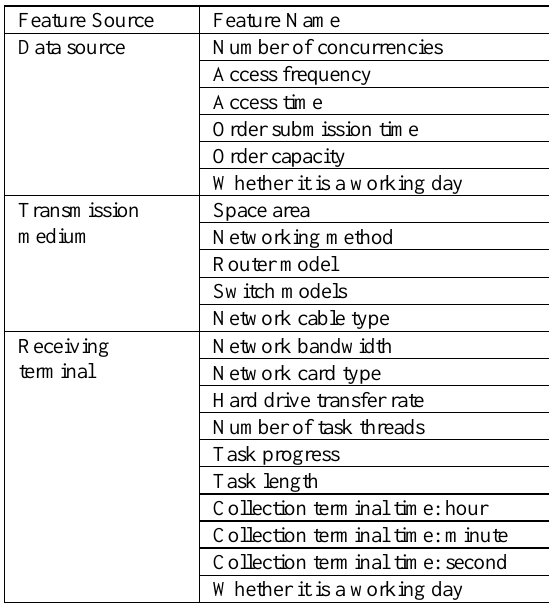
Table 1 . Selected features affecting network transmission